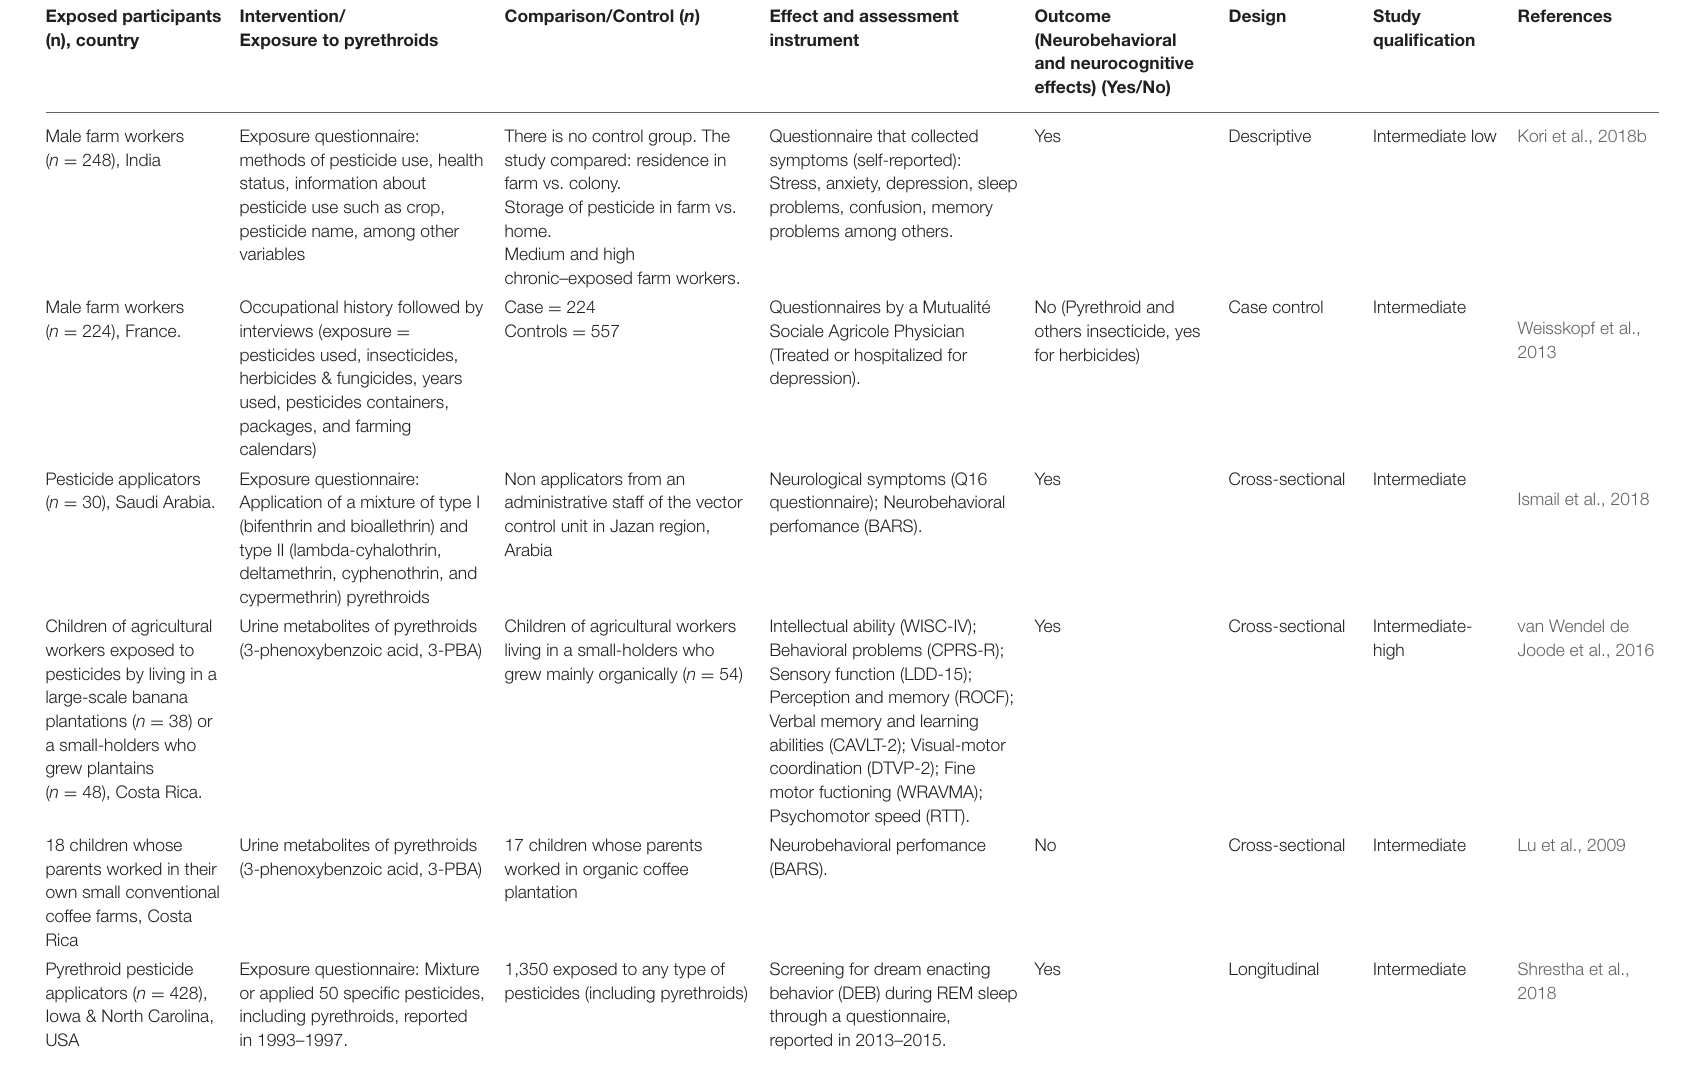
TABLE 1 | Evidence of exposure to pyrethroids and neuro outcomes in adolescent and adult farmers and children of agricultural workers. Exposed participants (n),